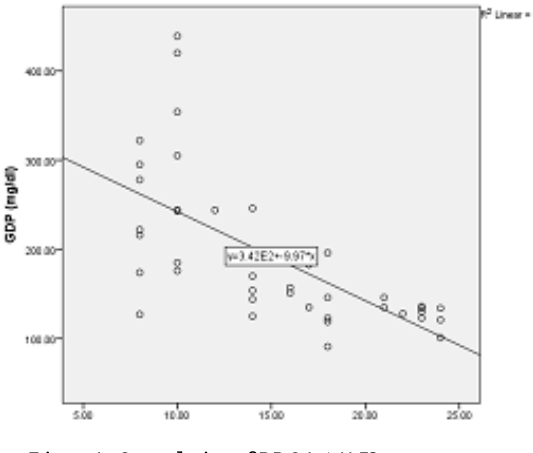
Figure1. Correlationof PROLANIS Implementation and Fasting Blood Sugar